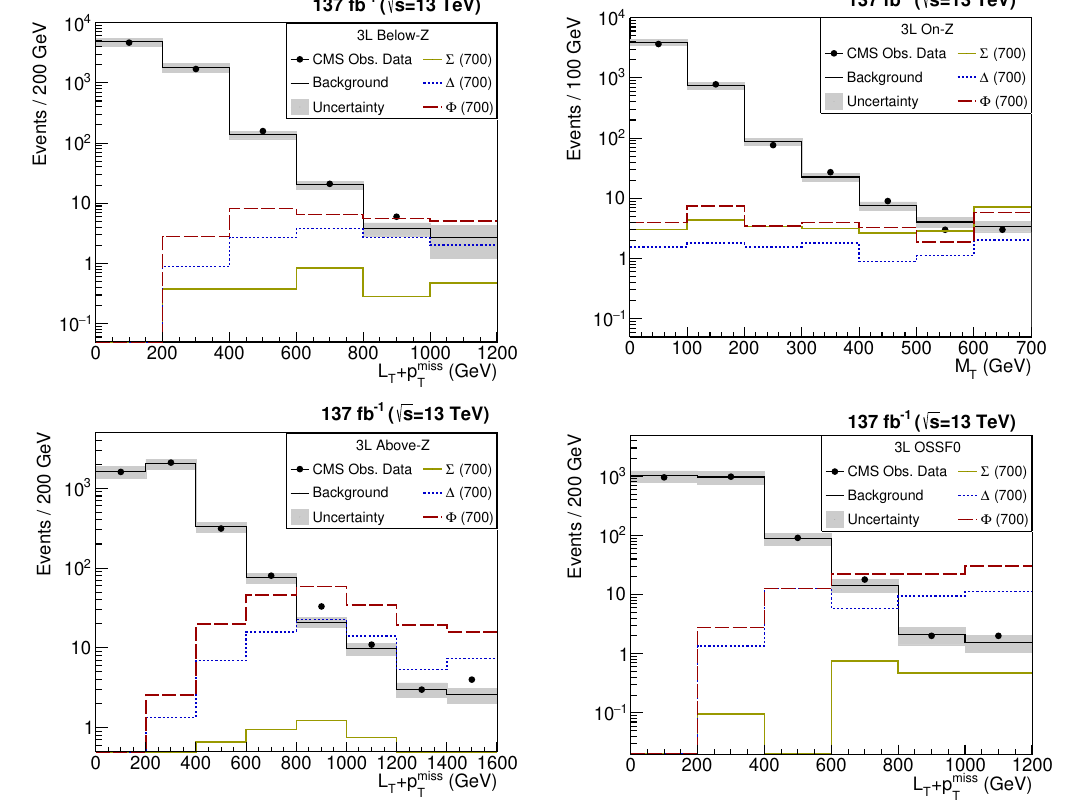
Figure 8 . For the signal regions 3L below-Z (upper left), on-Z (upper right), above-Z (lower left) and OSSF0 (lower right), the total expected SM backgrounds are shown as a histograms with black line, whereas the total observed events are shown as big black dots. The gray bands represent the total (systematic and statistical) uncertainty of the background estimation. The signal predictions for the three benchmark points are also shown. See text for